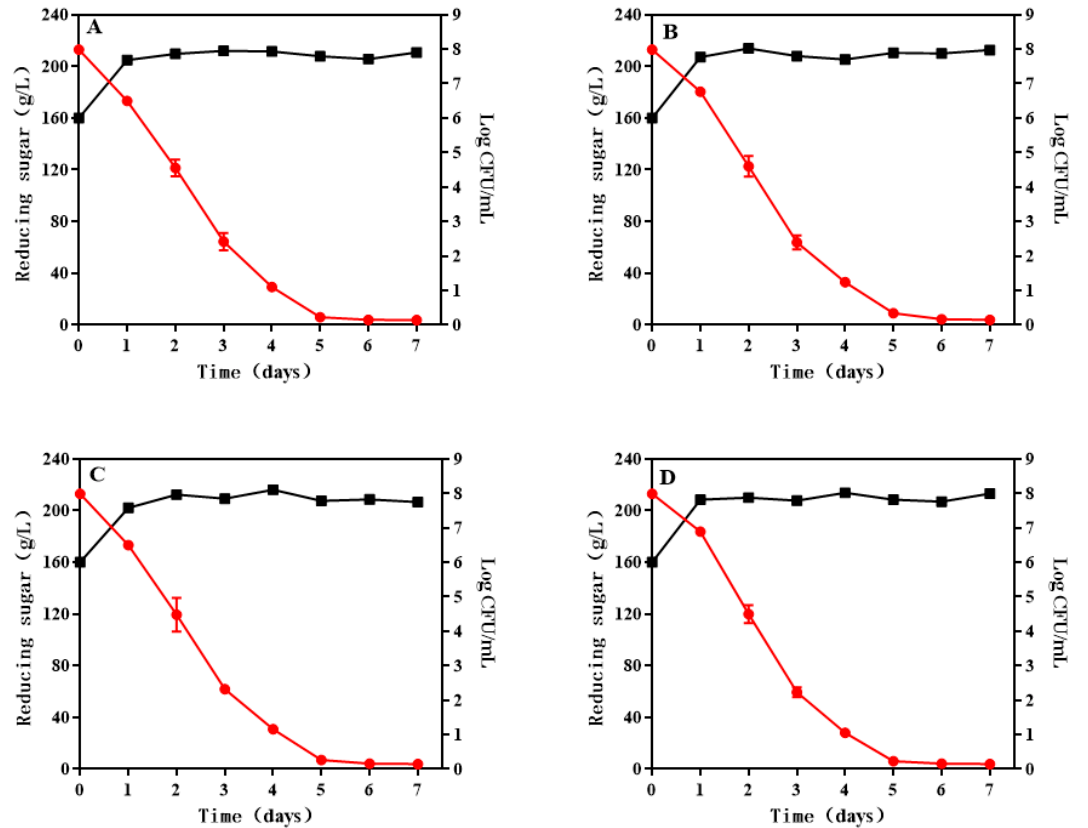
Figure 1. Growth and sugar consumption kinetics of S. cerevisiae during wine fermentation. ( A ) Control; ( B ) SLY-4EW; ( C ) HX-13EW; ( D ) F2-24EW; - ■ -Growth kinetics; - ● -Sugar consumption kinetics.